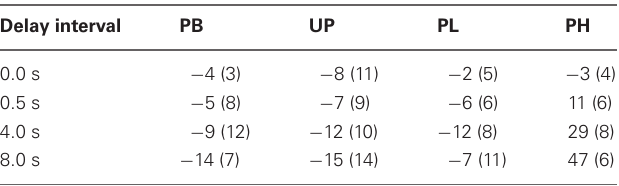
Table 4 | Means (SDs) for % change in visuospatial working memory in the association phase.